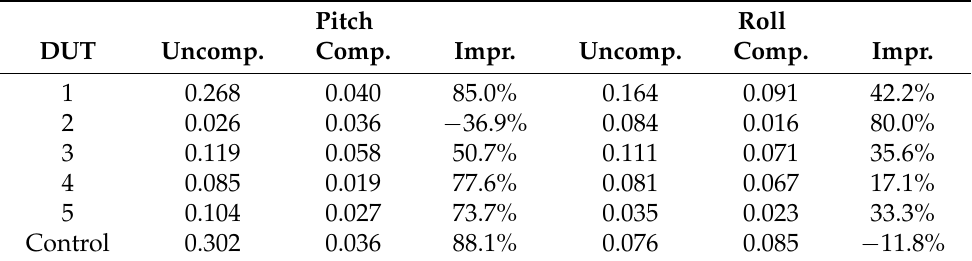
Table 9. Euler angles standard deviation before and after compensation